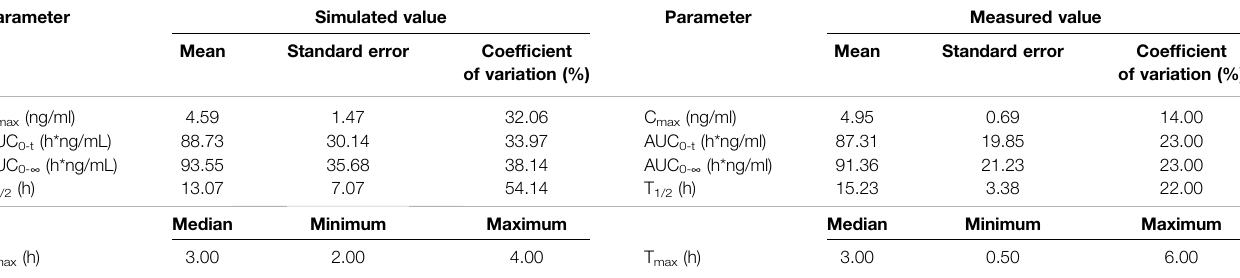
TABLE 4 | Comparison of measured PK values following oral administration of 1 mg varenicline in Chinese and simulated PK values in 300 Chinese virtual subjects. Parameter Simulated value Parameter Measured value Mean Standard error Coef fi cient Mean Standard error Coef fi cient of variation (%) of variation (%) C max (ng/ml)